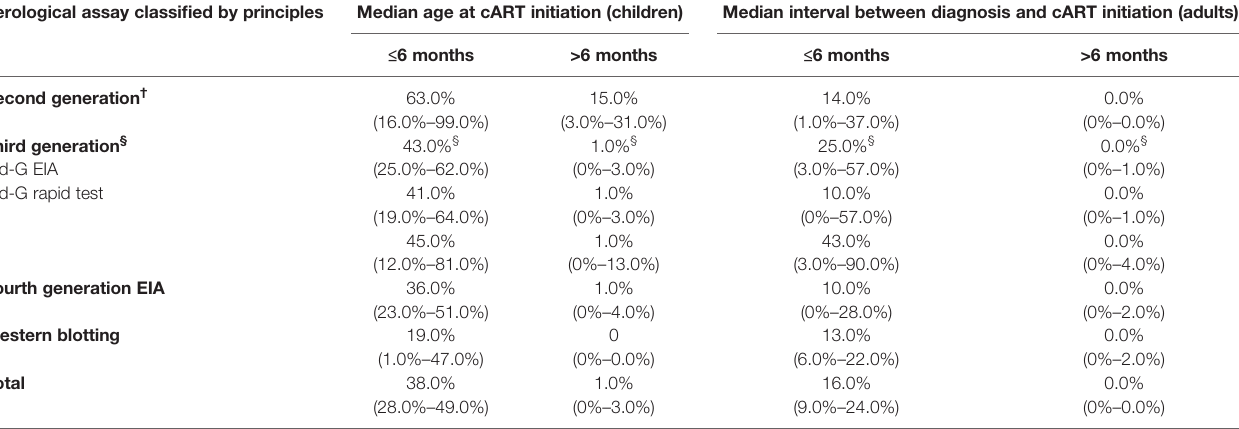
TABLE 3 | The pooled frequency of seronegativity (95% CI) for HIV-1 serological assays in cART-treated population strati fi ed by detection principles and timing of antiretroviral therapy started. Serological assay classi fi ed by principles